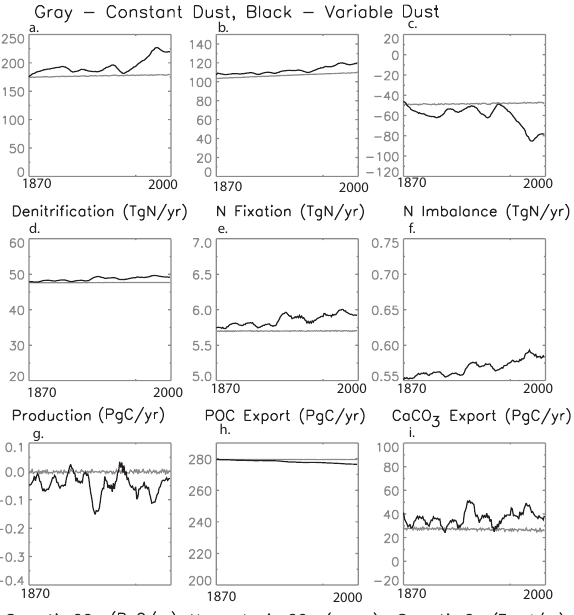
Fig. 8. Modeled ocean biogeochemical responses to desert dust changes for denitrification (a) , nitrogen (N) fixation (b) , reactive nitrogen imbalance (c) , primary production (d) , particulate organic export (POC) (e) , calcium carbonate export (CaCO 3 ) (f) , sea-air carbon dioxide fluxes (f), atmospheric CO 2 (g) , and sea-air oxygen fluxes (h) .